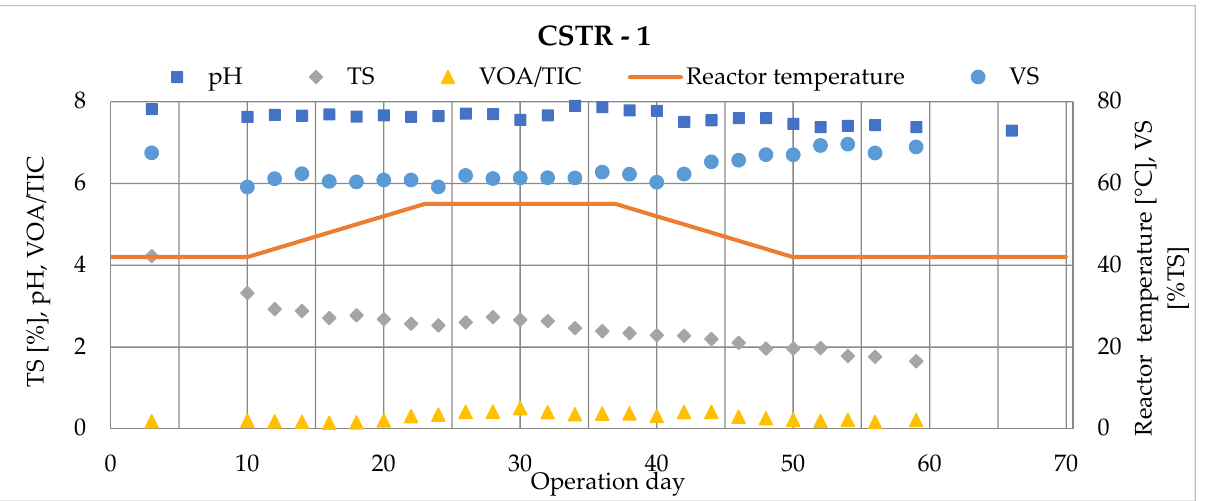
Figure 8. Results of laboratory analyses in CSTR-1.